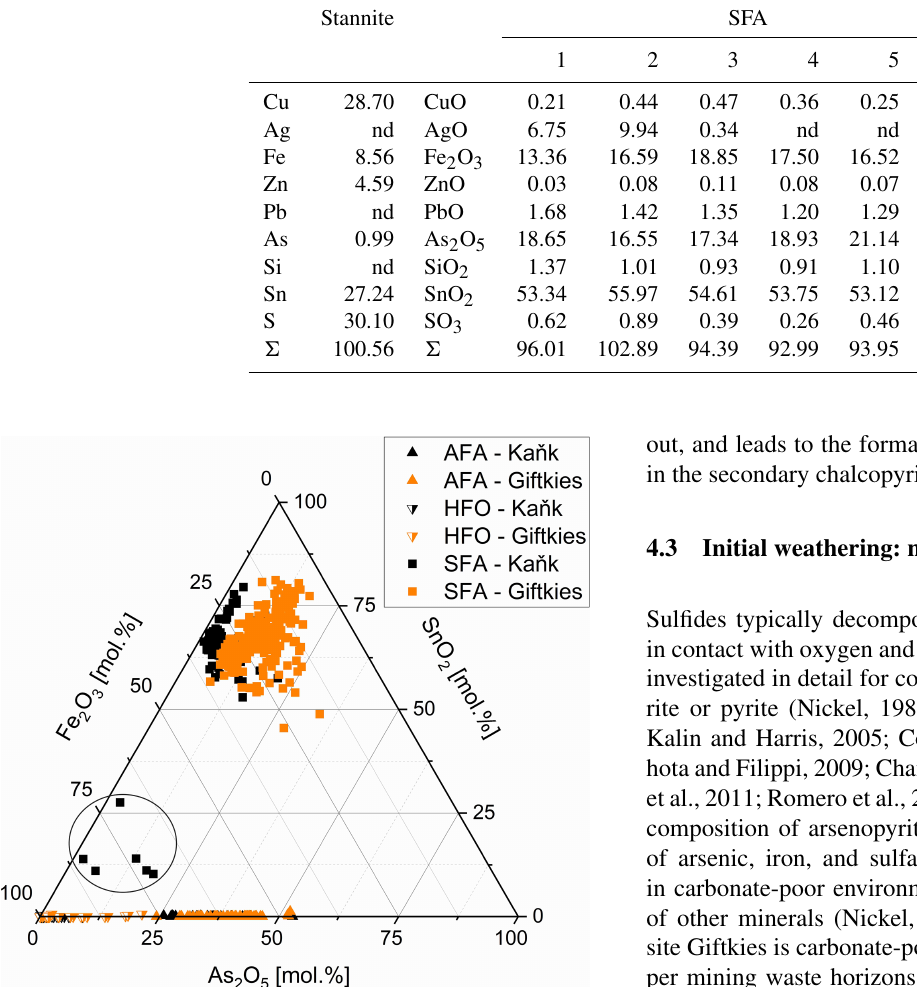
Figure 5. Fe 2 O 3 , As 2 O 5 , and SnO 2 abundance in SFA (filled squares), AFA (filled triangles), and HFO (half-filled triangles) from Giftkies (orange) and Kaˇnk (black); samples within circle are related to chalcopyrite I (all plotted data are normalized to